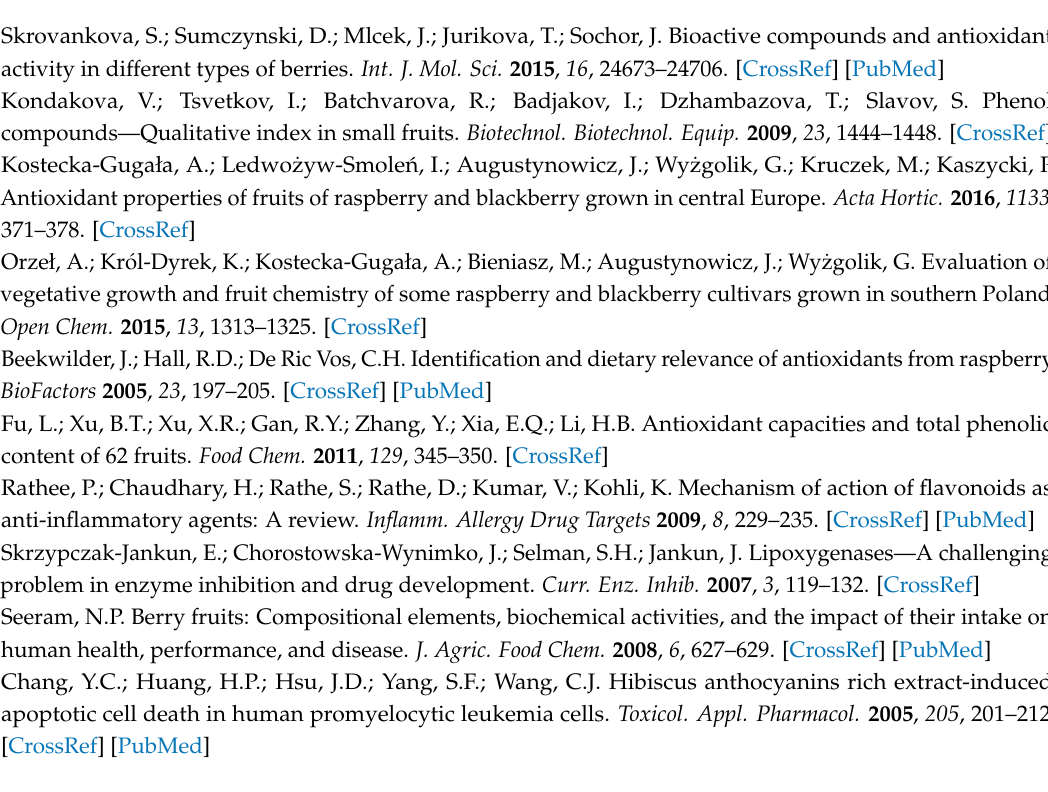
Supplementary Materials: The following are available online, Figure S1: HPLC chromatograms of anthocyanin fractions of (A) raspberry anthocyanin-rich fraction (RARF) and (B) juice anthocyanin-rich fraction (JARF), Figure S2: HPLC chromatograms of phenolic fractions of A) raspberry phenolic fraction (RPF) and B) juice phenolic fraction (JPF). Table S1: Correlation between antioxidant activity and inhibitory and antiproliferative activity of tested extracts, Table S2: Cell viability [%] of J.45 and HL60 cell lines exposed to increasing amounts [microliters] of analyzed